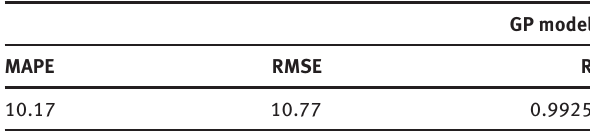
Table 9 Performance criteria of GP model.